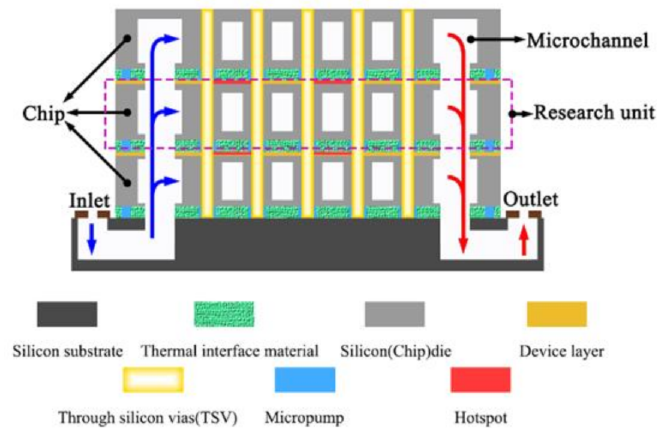
Figure 1. Schematic diagram of 3D stacked chips with microchannel hybrid heat sink [11].